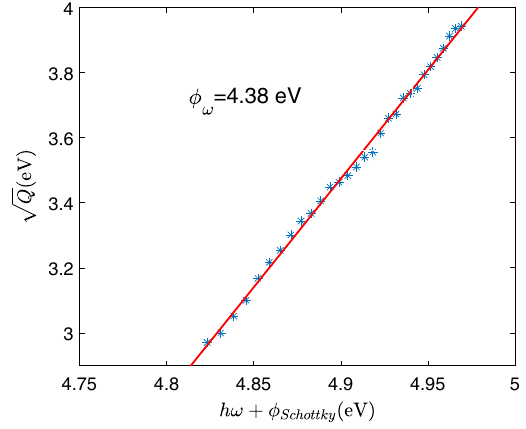
FIG. 6. An estimation of intrinsic work function by fitting the ffiffiffiffi p Q vs ð h ω þ ϕ Þ curve of Schottky